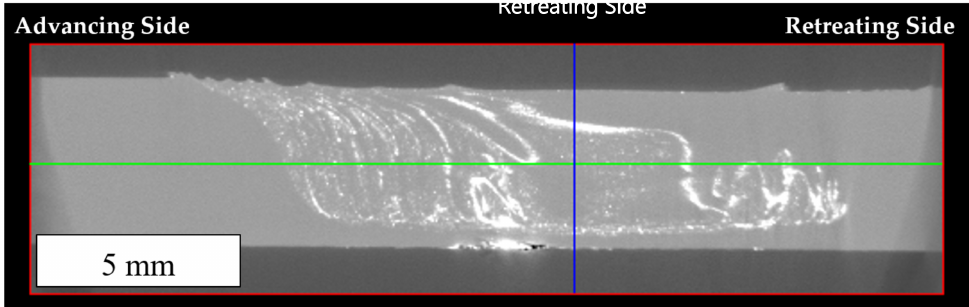
Figure 6. CT image of cold welding with WZ 2-20-8.